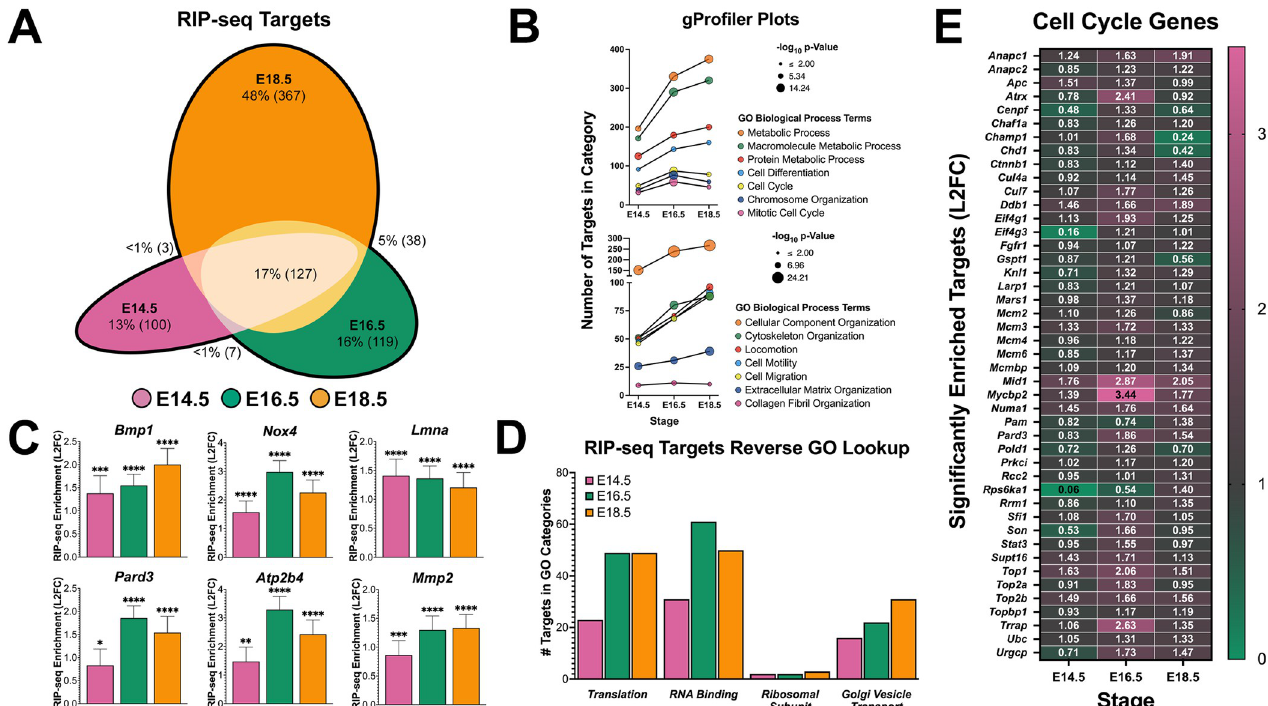
Fig 6. RIP-seq reveals conservation of many DND1 targets at all 3 stages. A: Euler plot of temporal distribution (E14.5 (pink), E16.5 (green), E18. (orange)) of significantly enriched transcript targets of DND1. B: Bubble plot from g:Profiler analysis of significantly enriched transcript targets of DND1 showing change in number of targets (Y-axis) for prominent GO biological processes related to cell cycle and metabolism (upper), and cell movement and ECM- cytoskeleton organization (lower) the -log10 P-value of each GO biological process is denoted by bubble size with developmental stages progressing along the X-axis. C: Bar graphs showing target enrichment as a function of L2FC at E14.5, E16.5, E18.5. RIP-seq enrichment P-value (DESeq2): not significant (ns), < 0.05 ( � ), < 0.01 ( �� ), < 0.001 ( ��� ), < 0.0001 ( ���� ). D: number of significantly enriched transcript targets at E14.5, E16.5, E18.5 for GO biological processes identified in hiloRNA-seq analysis (Fig 4A): translation, RNA binding, ribosomal subunit, Golgi vesicle transport. E: Heatmap of significantly enriched transcript targets at E14.5, E16.5, E18.5 for the GO biological process cell cycle.